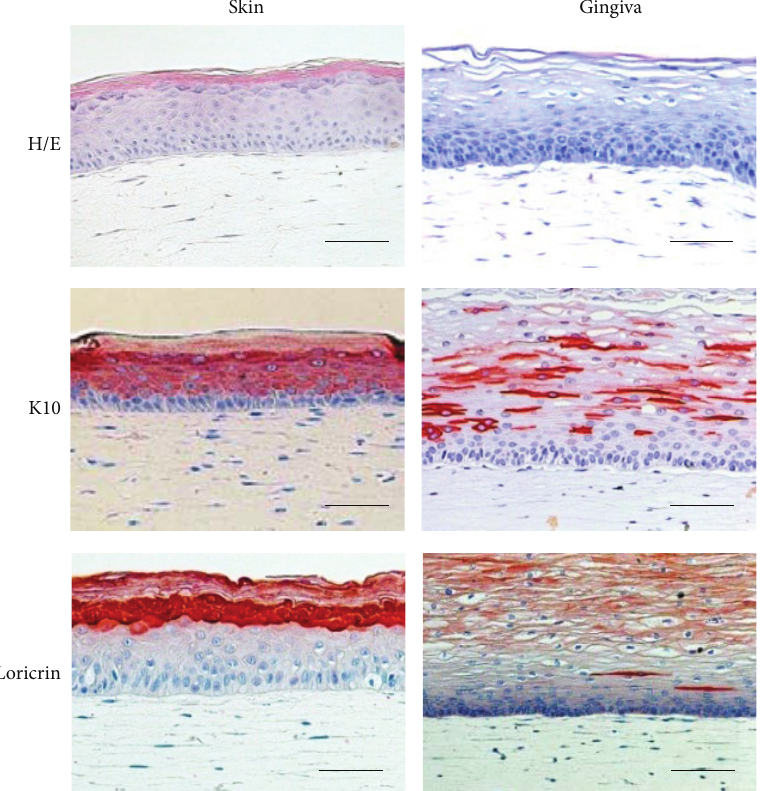
Figure 1: Full thickness tissue engineered skin and gingiva. Haematoxylin and eosin (H/E) staining and immunohistochemical analysis with keratin 10 (K10) and loricrin in tissue sections illustrate the different representative characteristics of skin and gingiva equivalents. Scale bar: 50 𝜇